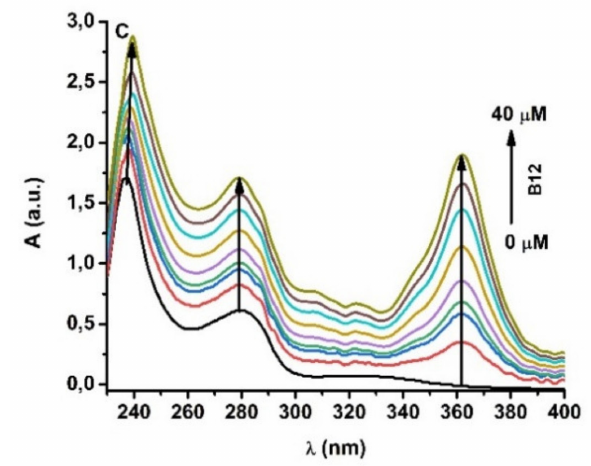
Figure 1. The effect of vitamin solutions on the UV absorption spectra of BSA-LT4 in the presence of vitamin solutions in different concentrations: Vitamin concentrations are: Vitamin C ((0–70) µ M) ( A ), folic acid ((0–70) µ M) ( B ) and vitamin B12 ((0–40) µ M) ( C ). The significance of the colors is explained by the arrow in the figure that indicates the direction of increase of the concentration of each compound in the 3